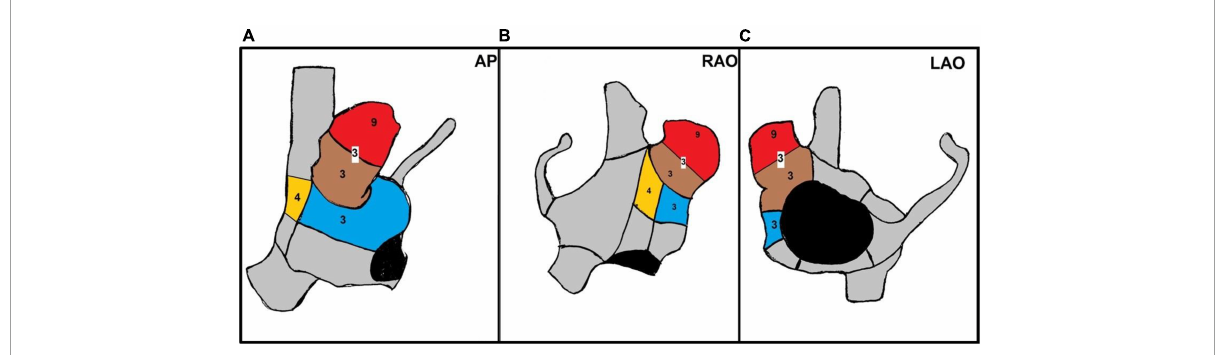
FIGURE3 Anatomical distribution of AF termination sites in RAAF patients. Three dimensional shells of the right atrium [panel A: antero posterior view (AP), panel B: right anterior oblique (RAO) 30 ◦ view, panel C: left anterior oblique (LAO) 30 ◦ view]. Colored sections show anatomical regions of AF termination sites during ablation with the corresponding patients number. In red the RAA apex, in brown the RAA base, in blue the upper half of the right atrial free wall, in yellow the upper half of the crista terminalis. In three patients several AF termination sites were observed both in the apex and base of the RAA. In one patient, transient organization into atrial tachycardia was observed after RAA electrical isolation during ablation at the base.